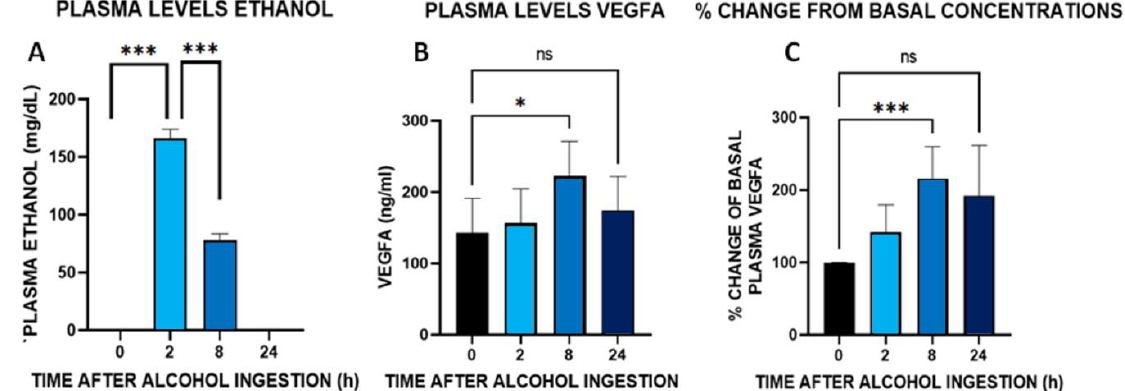
Figure 6. Plasma concentrations of alcohol ( A ) and VEGFA ( B ) at 2, 8 and 24 h after alcohol (100 g) ingestion in male ( n = 9 – 10) healthy volunteers. 0 represents the time of ingestion. Alcohol resulted in increase in plasma concentrations of VEGF 8 h after its ingestion (Friedman ’s non-parametric test for repeated measures, * p < 0.05 versus 0 time). ( C ) Percentage of change of VGEFA calculated over basal concentrations (ANOVA with repeated measures, *** p < 0.001 versus 0 time). ns= non-significant.